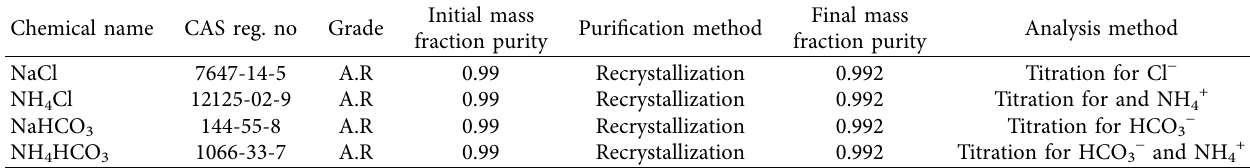
Table 1: Reagents used in this